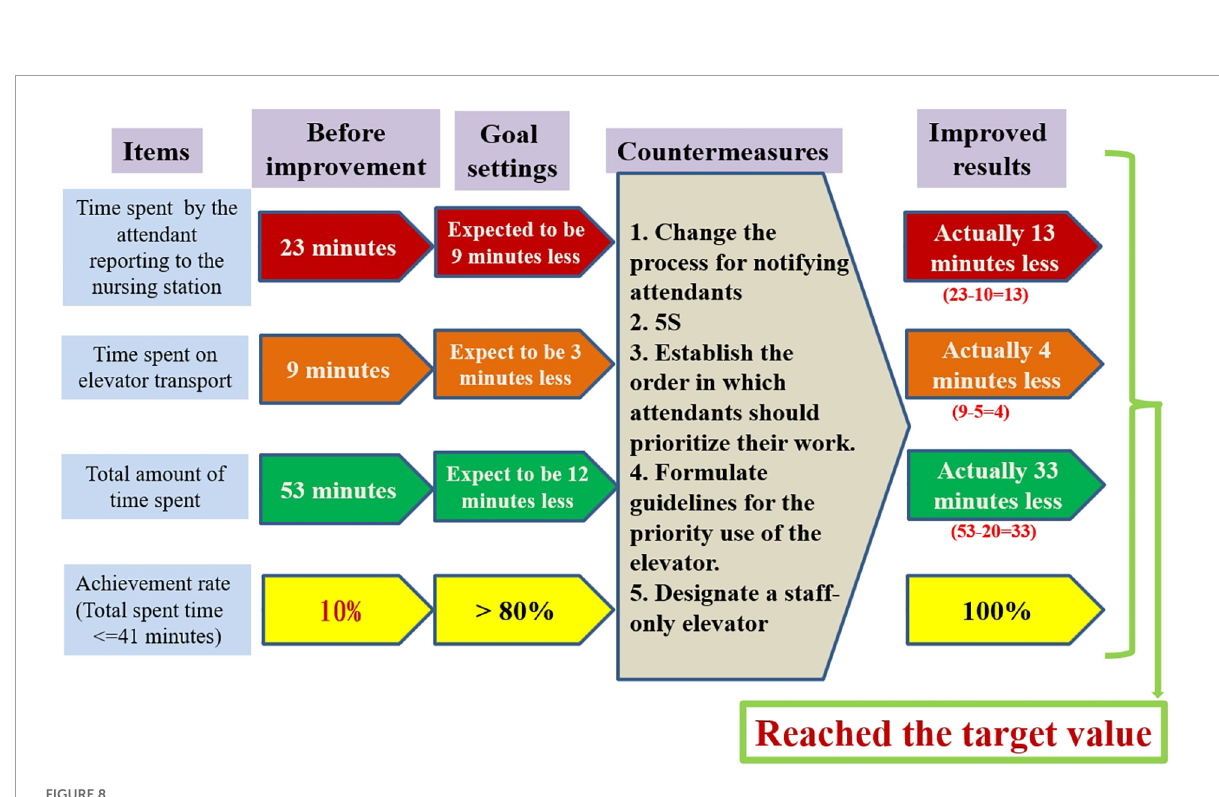
FIGURE8 Comparison of the results before and after the